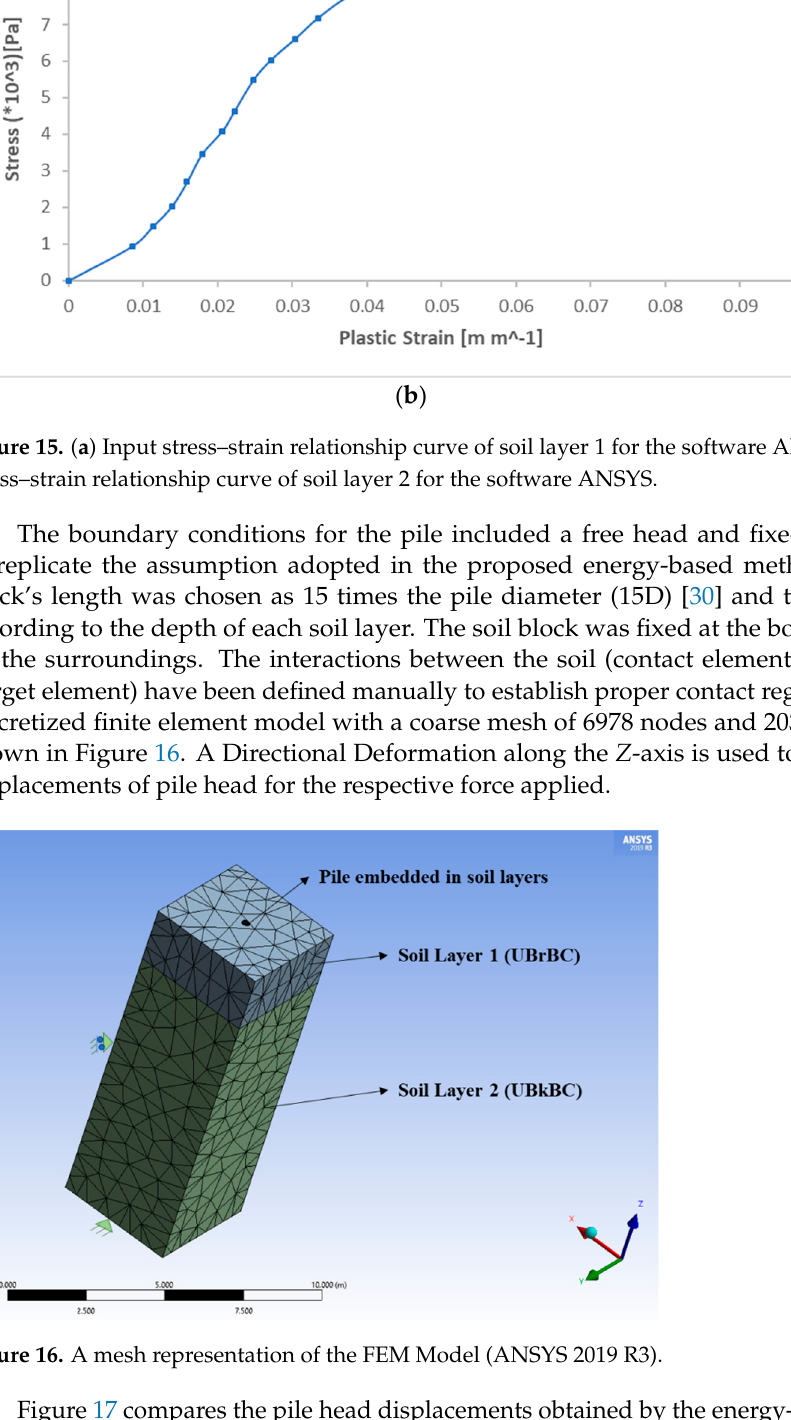
Figure 17. Pile displacements resulting from FEM Analysis. 5. Discussions